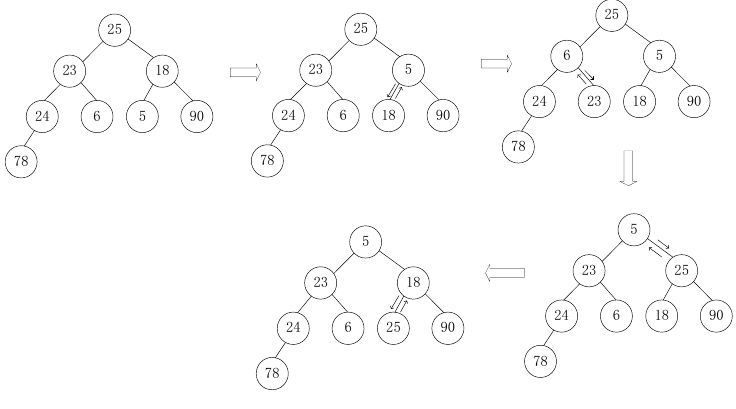
Figure 2. Minimum heap sort